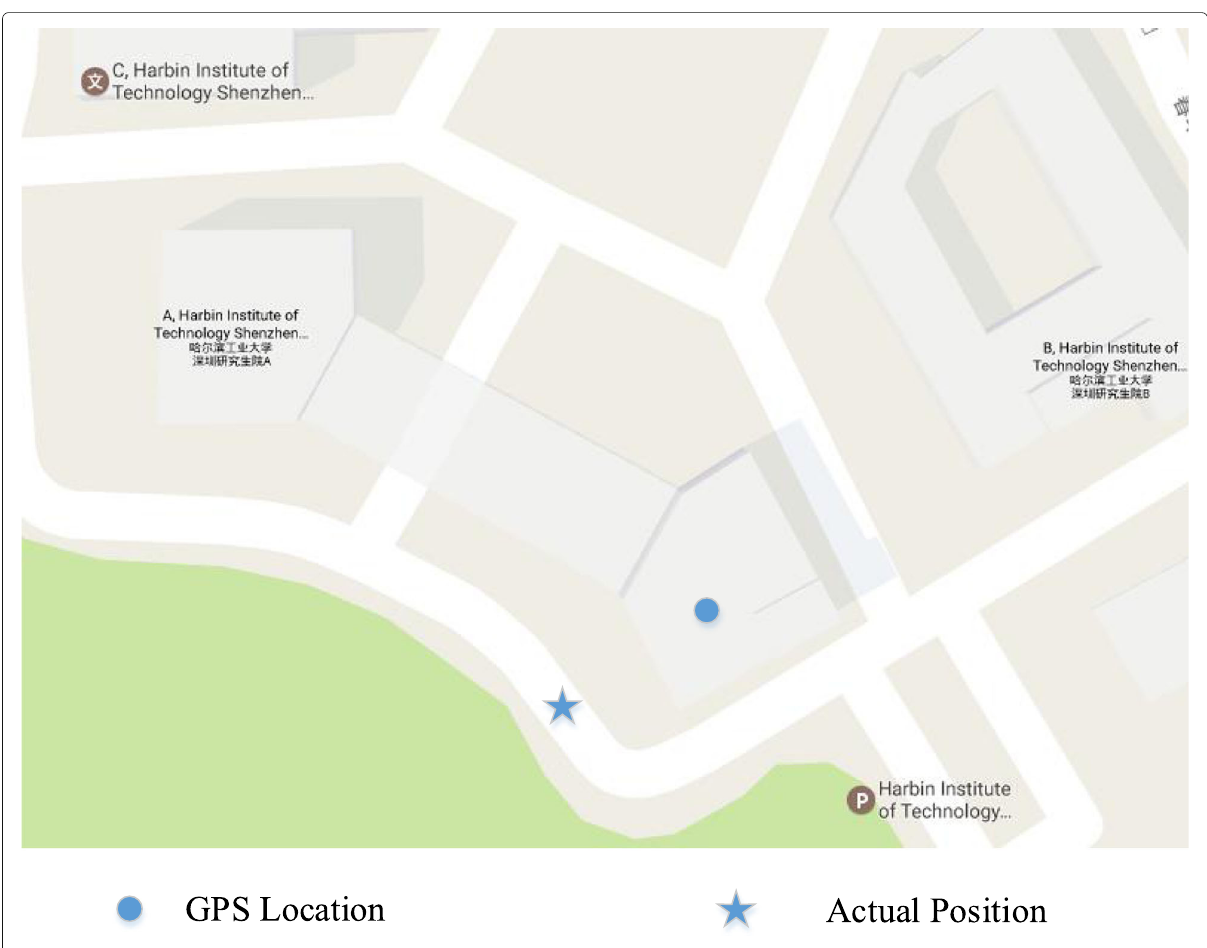
Fig. 1 GPS: localization outlier in interference